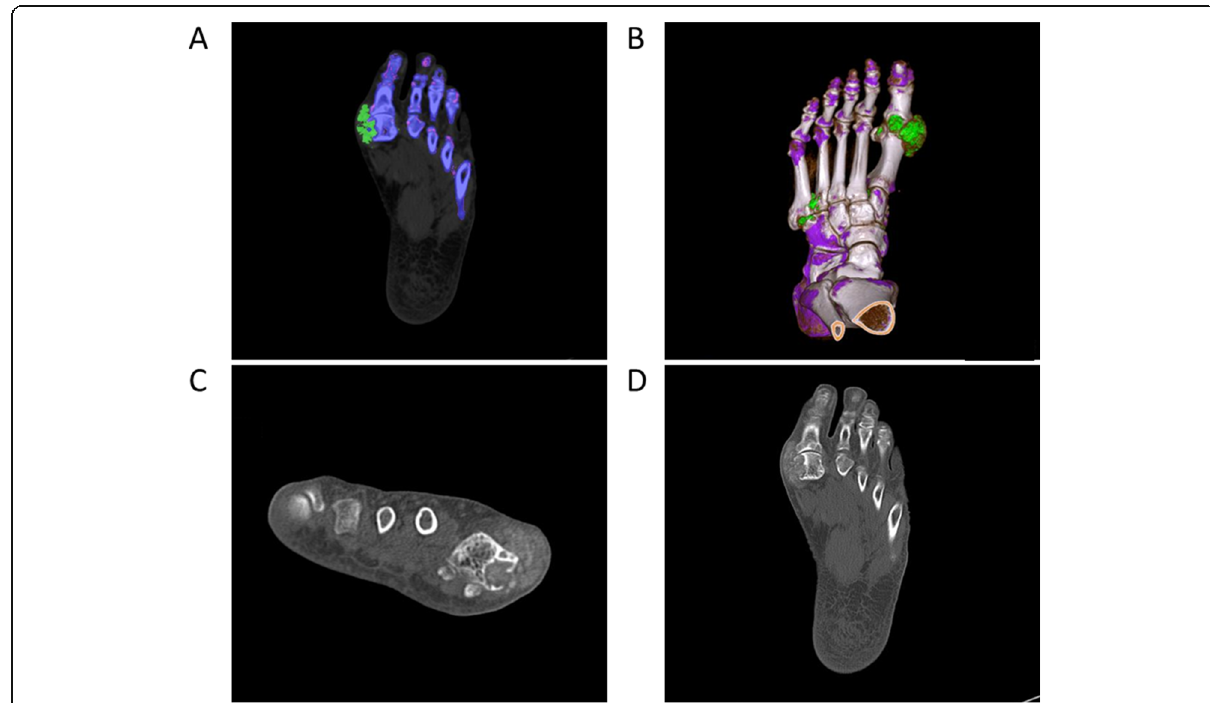
Fig. 1 Dual-energy computed tomography (DECT) images. A) Color mapping showing uric acid deposits (green) in the periarticular tissues of the first MTP joint. B) Three-dimensional DECT image with color mapping showing tophi (green) in the first MTP joint. C, D) Two-dimensional CT image showing high-attenuation tophi associated with erosions in the first MTP